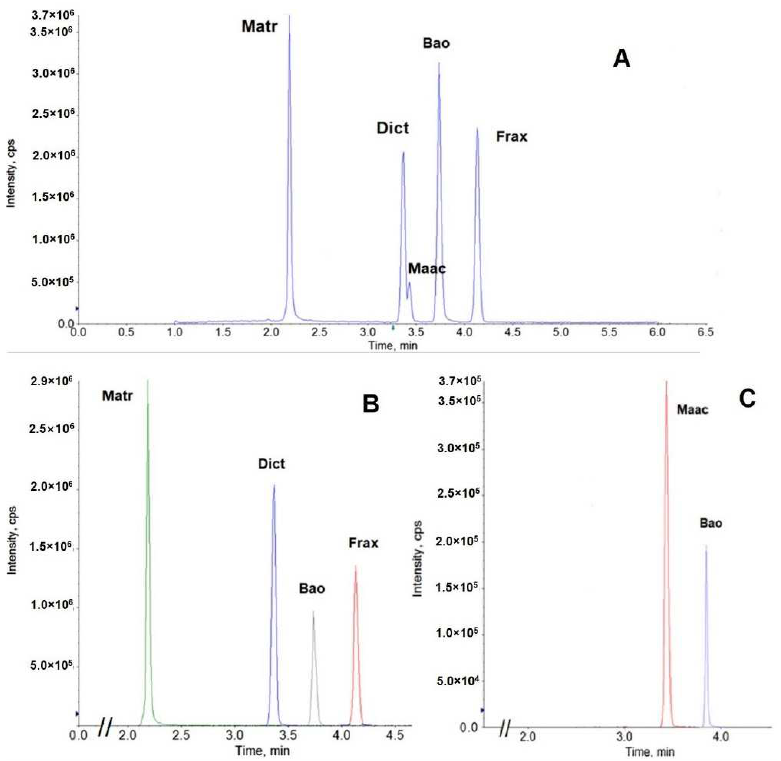
Figure 2. UPLC-MS/MS chromatogram of ATB key active compounds matrine (Matr), dictamnine (Dict), maackiain (Maac), fraxinellone (Frax) and the internal standard (Baohuoside I-Bao). ( A ) Total ion chromatogram, ( B ) chromatogram in positive mode, ( C ) chromatogram in negative mode.